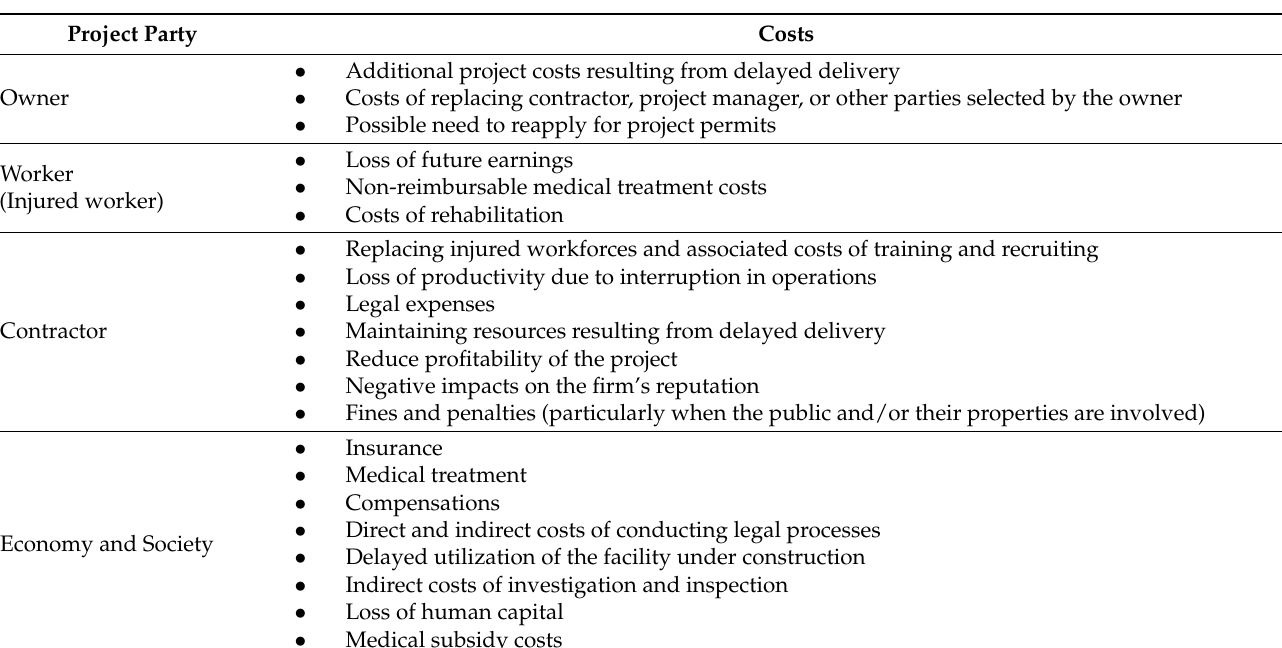
Table 1. Consequences and costs of construction job site